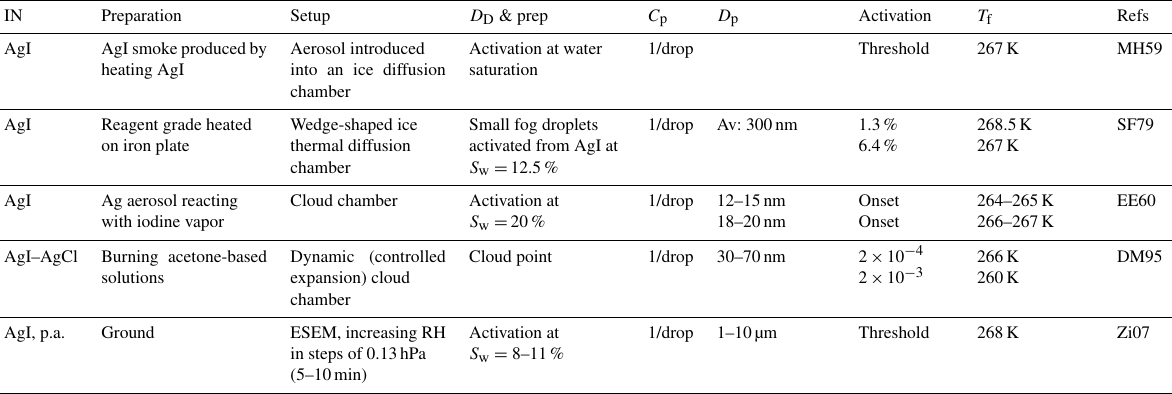
Table 3. Condensation freezing studies. IN: ice nuclei; D D : droplet diameter; C p : particle concentration; D p : particle diameter; T f : freezing temperature. S w : supersaturation with respect to water. References: MH59 – Mason and van den Heuvel, 1959; SF79 – Schaller and Fukuta, 1979; EE60 – Edwards and Evans, 1960; DM95 – DeMott, 1995; Zi07 – Zimmermann et al., 2007; ESEM – environmental scanning electron microscopy.